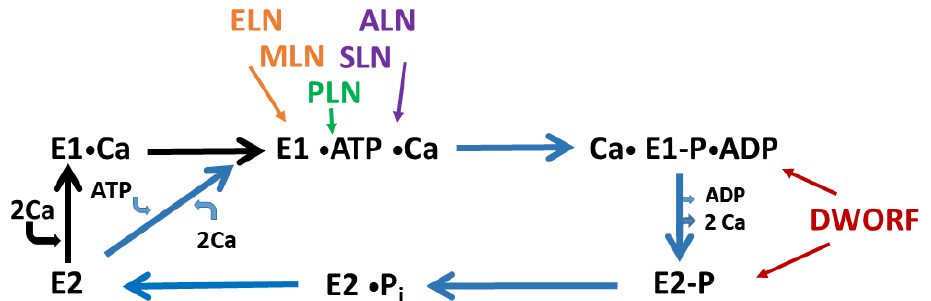
Figure 3. The effect of regulins on the catalytic cycle of SERCA. The Post–Albers scheme has been modified following [9] since SERCA in physiological condition is likely to convert from E2 directly to the E1 • ATP • Ca stage. The reported actions of micropeptides on SERCA conformations [66] are indicated by arrows. Micropeptides showing similar effects on SERCA activity have the same colour (i.e., MLN and ELN both influence Vmax but not K Ca2+ are orange, SLN and ALN both alter Vmax and K Ca2+ are purple). Note that DWORF acts on two low calcium affinity stages which are different from the stage affected by PLN.